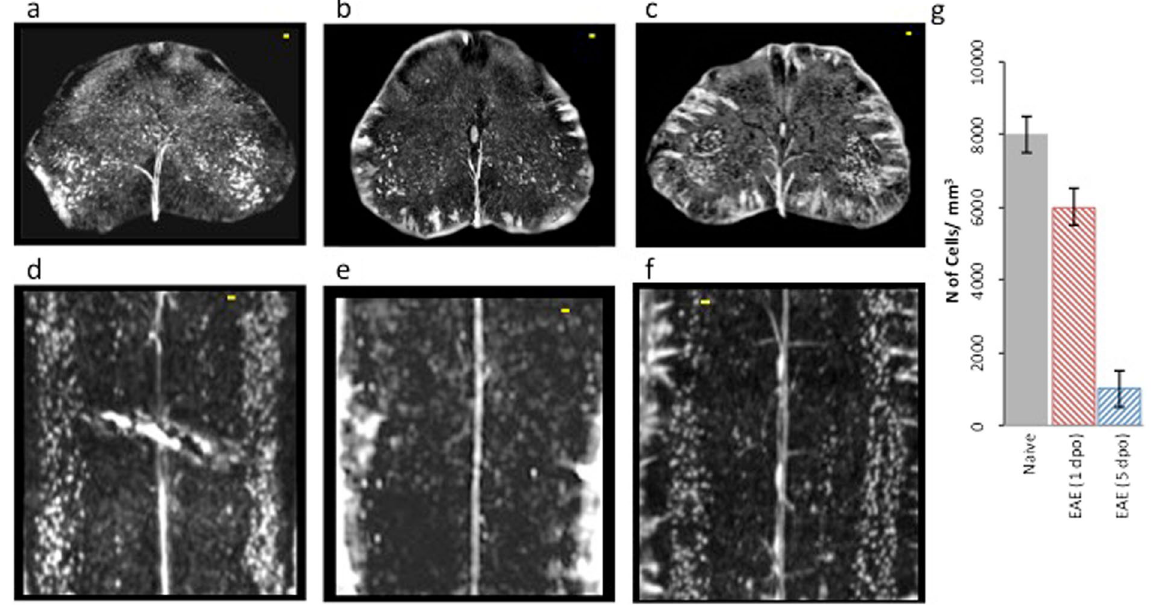
Figure 7. Effect of MSC treatment on the alteration of the neuronal network in EAE. Representative axial ( a – c ) and longitudinal ( d – f ) XPCT images of spinal cord samples from naïve ( a , d ), and untreated ( b , e ) or MSC- treated ( c , f ) EAE-affected mice at 5 dpo. Neurons appear as white spots. ( g ) Quantification of the number of cells for naïve, and untreated EAE at 1 and 5 dpo. These data were obtained on the same set of samples used to assess vascular alteration in Fig. 1g. Scale bar: 20 μ m. The pixel size is 3.5 microns and the spatial resolution is 7